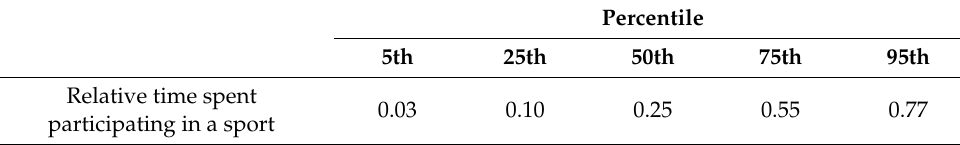
Table 2. Sample distribution of relative time spent participating in a